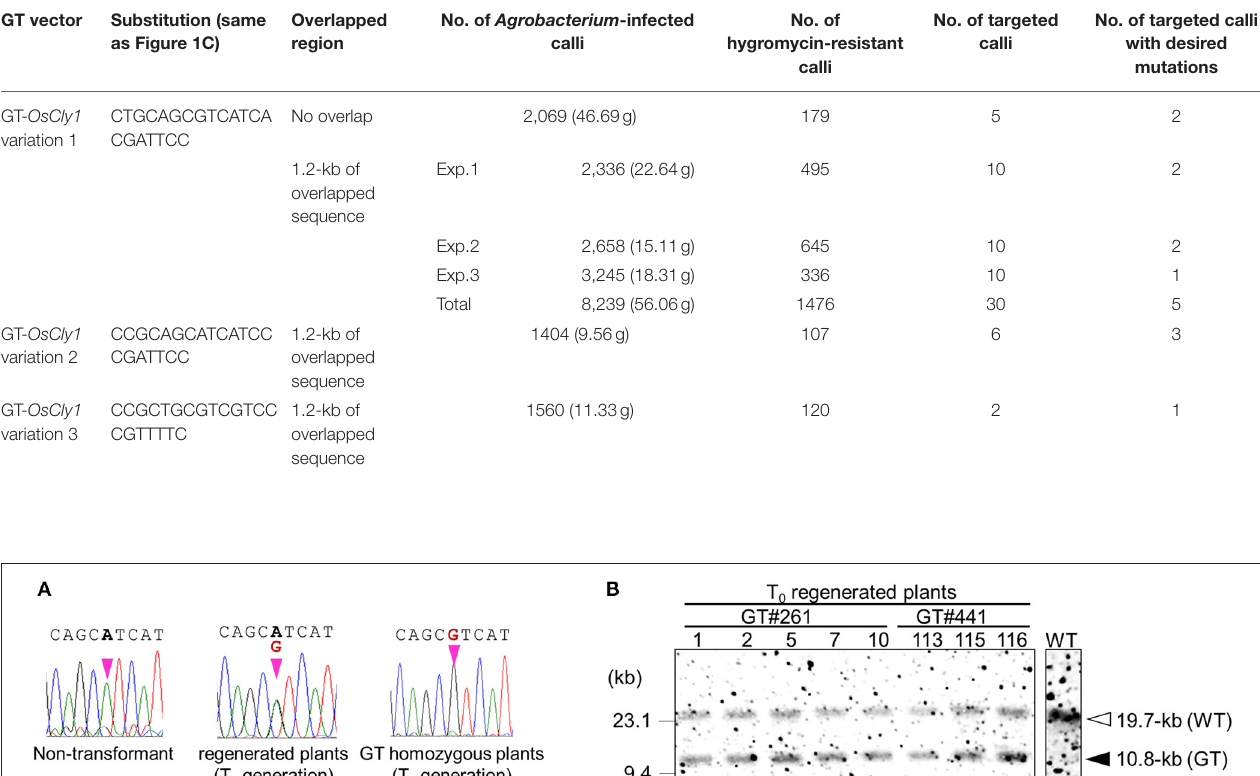
TABLE 1 | Summary of GT experiments for OsCly1 locus.